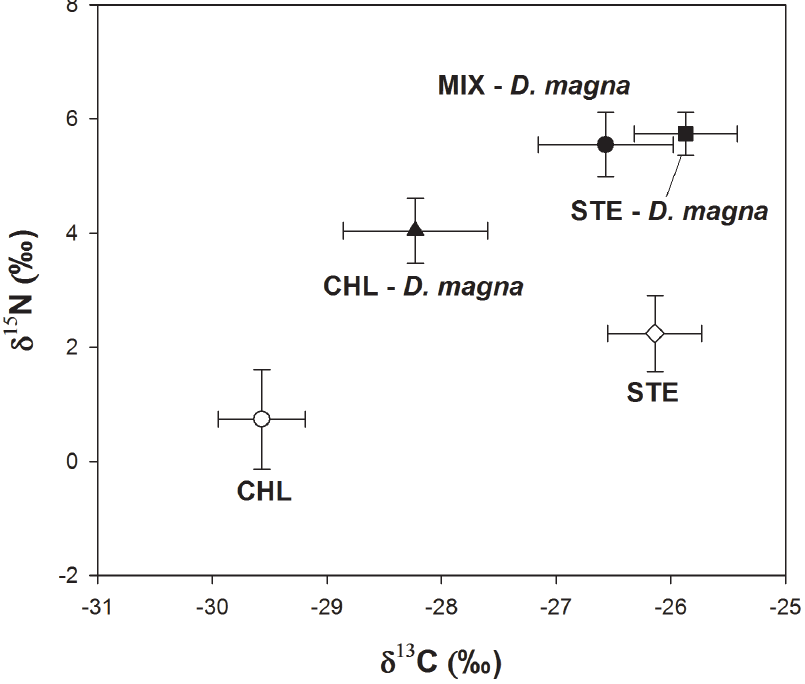
Figure 3. Results of the stable isotope analysis. CHL, C. vulgaris ; STE, S. hantzschii ; MIX, a mixture of both prey species. doi:10.1371/journal.pone.0095591.g003 PLOS ONE |